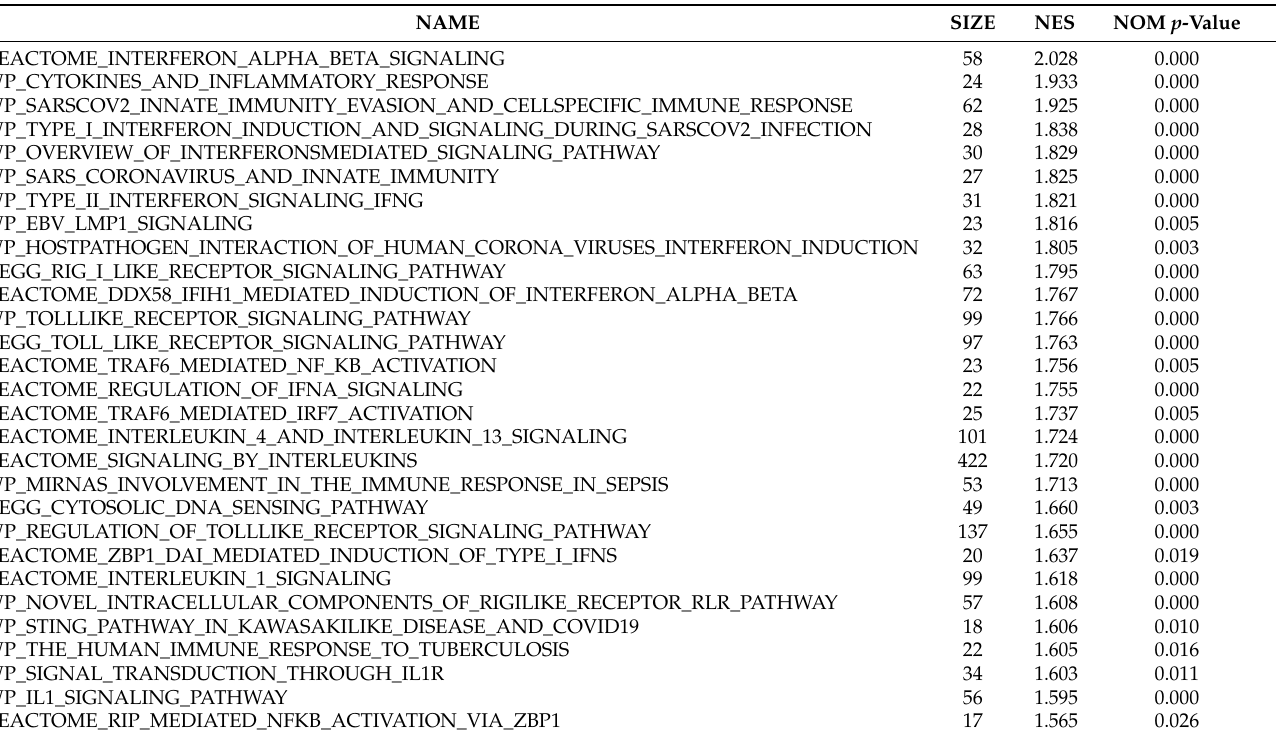
Figure 4. GSEA leading-edge analysis reveals that fucoidan activates a type I IFN response. ( A ) GSEA leading-edge analysis of significantly enriched gene sets from KEGG, Reactome, and WiKiPathways databases in the built-in C2 curated gene sets. The results are shown as a set-to-set diagram where the intensity of the green color directly correlates to the extent of the intersection between the leading- edge core genes of each gene set combination. The darker the color, the greater the overlap between subsets. ( B ) Representative GSEA enrichment plots from cluster A1 specifically related to type I IFN signaling and SARS-CoV-2 infection. False discovery rate (FDR) q value; normalized enrichment scores (NES). ( C ) Set-to-set diagram of GSEA based on transcription factor target database showing enrichment of STAT, IRF, NFkB target gene sets in fucoidan-treated BMDCs. ( D ) Venn diagram from Interferome analysis showing number of genes regulated by one or more IFN type (type I, II or III) among the 950 upregulated DEGs. Table 3. Gene sets in cluster A1 (Type I IFN